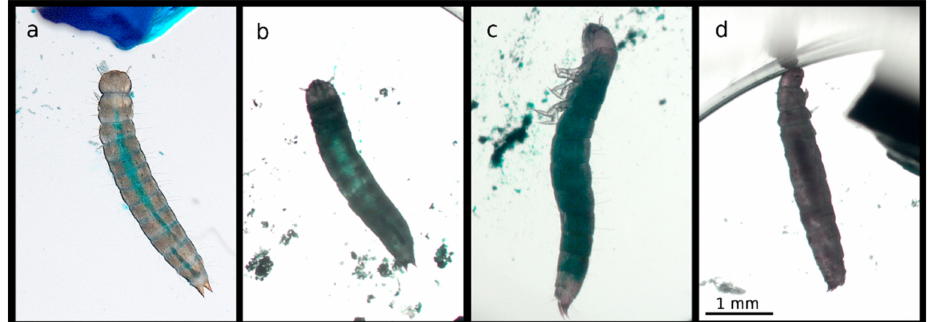
Figure 6. Phenotypes of T. castaneum larvae observed under the experimental conditions. ( a ) Healthy control larva with a well-defined digestive tract filled with blue-dyed agarose. ( b ) Dead larva showing a subtle Smurf phenotype upon B. thuringiensis (here tenebrionis ) exposure. ( c ) Dead larva showing a stronger Smurf phenotype upon B. thuringiensis (here tenebrionis ) exposure. ( d ) Dead larva showing a darkened digestive tract upon B. thuringiensis (here tolworthi ) exposure; this is the phenotype we encountered the most frequently. The pictures represent larvae exposed to either B. thuringiensis tenebrionis or tolworthi ; however, they are representative of the phenotypes induced by both B. thuringiensis tenebrionis and tolworthi . The scale represented on the rightmost picture is common to all the panels of the